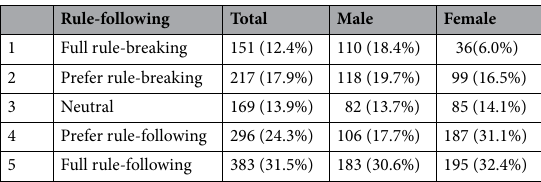
Table 1. Distribution of sensitivity to norms